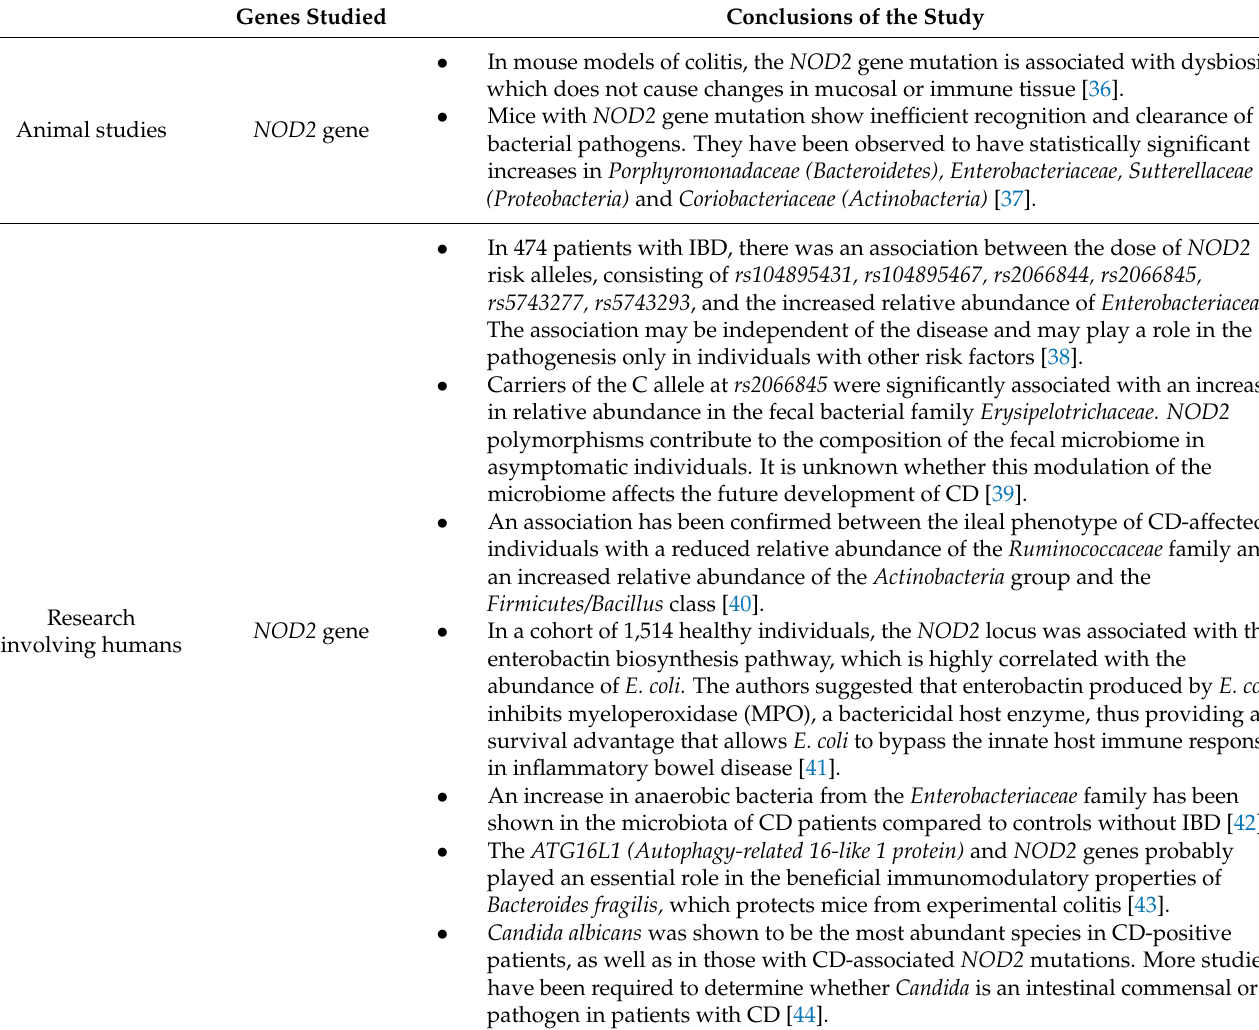
Table 1. The NOD2 gene mutation and its impact on the microbiota in IBD. Genes Studied Conclusions of the Study